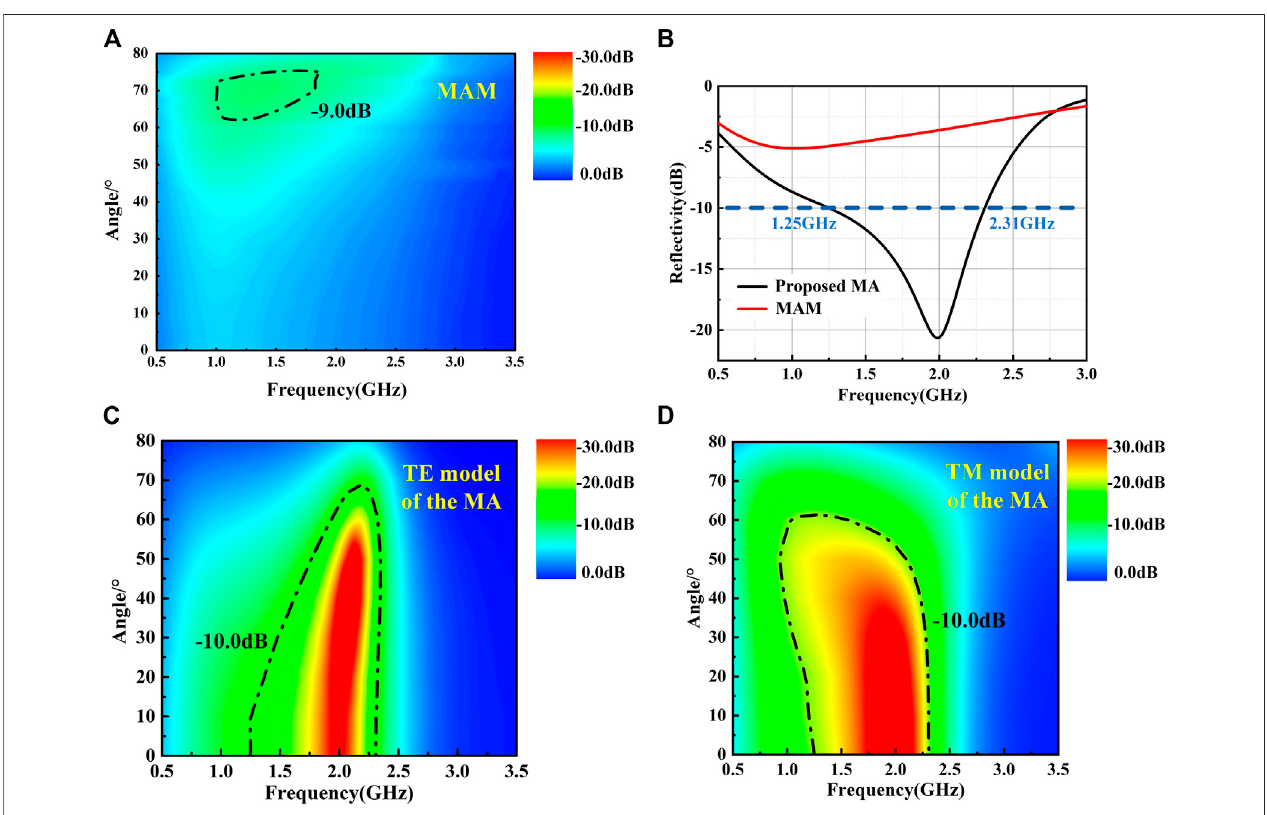
FIGURE 3 | (A) The simulated re fl ectivity spectra of the MAM at different angles. (B) The re fl ectivity of the comparison between the proposed MA and MAM under normal incidence. The simulated re fl ectivity spectra of the proposed MA at different angles under (C) TE polarized waves and (D) TM polarized waves.